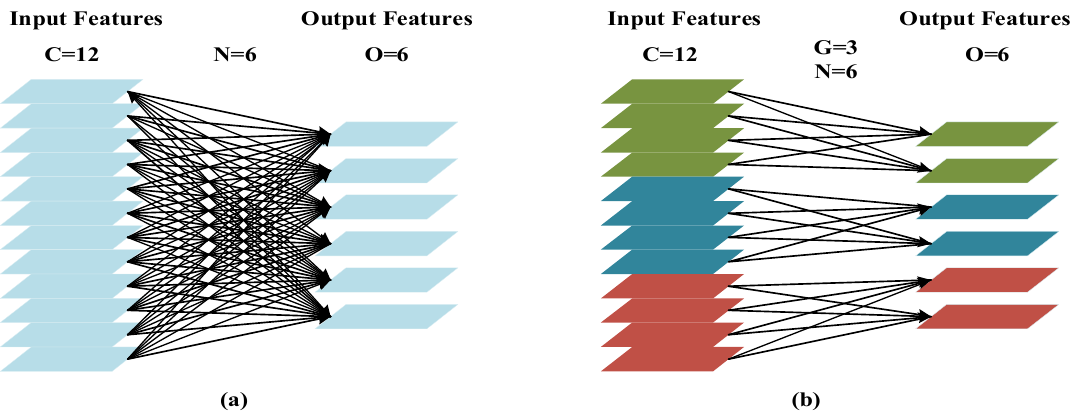
Figure 2. ( a ) Conventional Convolution ( b ) Group Convolution. C, N, G, and O correspond to the numbers of the channel, kernel, group, and output, respectively.